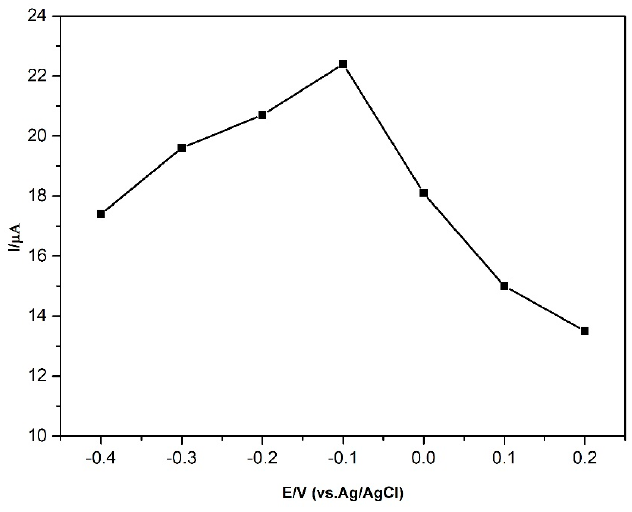
Figure 8. Effect of accumulation potential on the oxidation peak current of 2 μ M BPA (t dep : 60 s). Conditions: pH 7.0; frequency: 50 Hz; step amplitude: 40 mV; pulse amplitude: 5 mV.